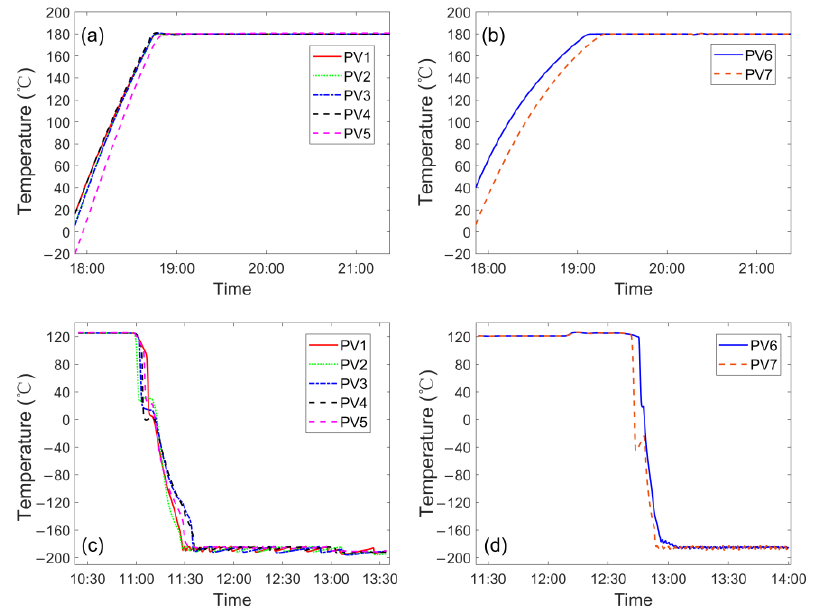
Figure 7. The temporal evolution curve of the temperature in the instrument cabin and the sample cabin. ( a ) Temperature raising process for the instrument cabin. ( b ) Temperature raising process for the sample cabin. ( c ) Temperature dropping process for the instrument cabin. ( d ) Temperature dropping process for the sample cabin.